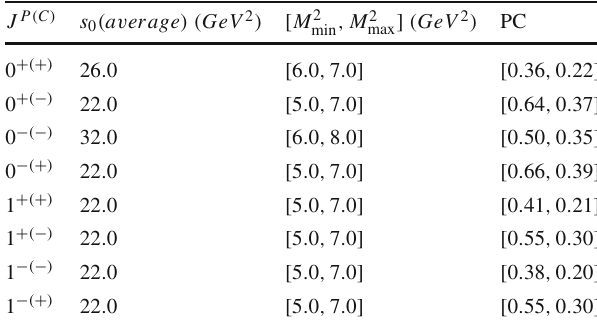
Table 1 Values of PC for different quantum numbers of the ground state charm-nonstrange hybrid mesons